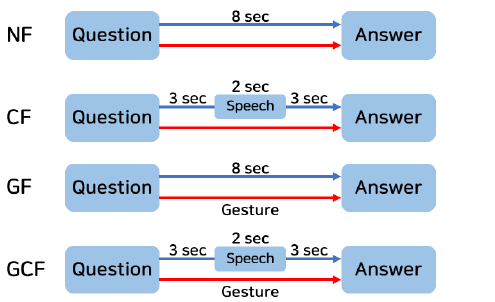
Figure 6. Experimental conditions (NF, CF, GF, and